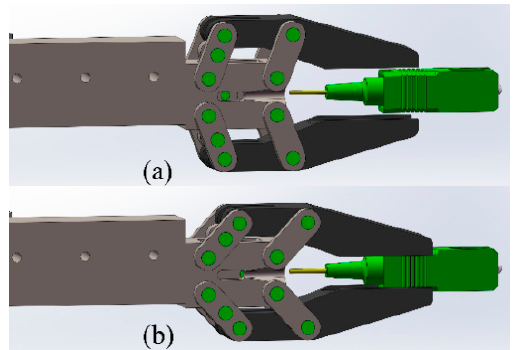
Figure 13. Two states of the rapier robot’s clamping device: ( a ) loosening; ( b ) clamping.